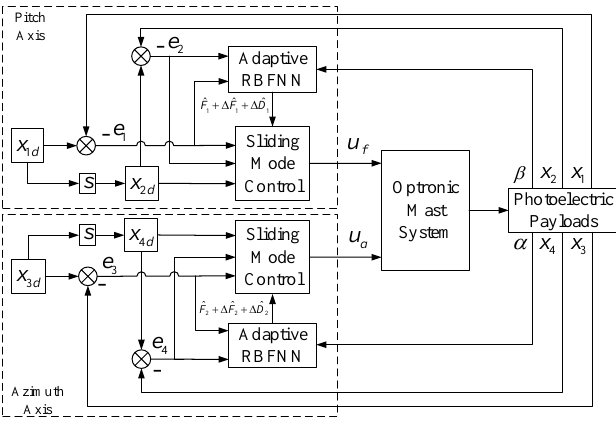
Figure 2. The block diagram of the proposed control